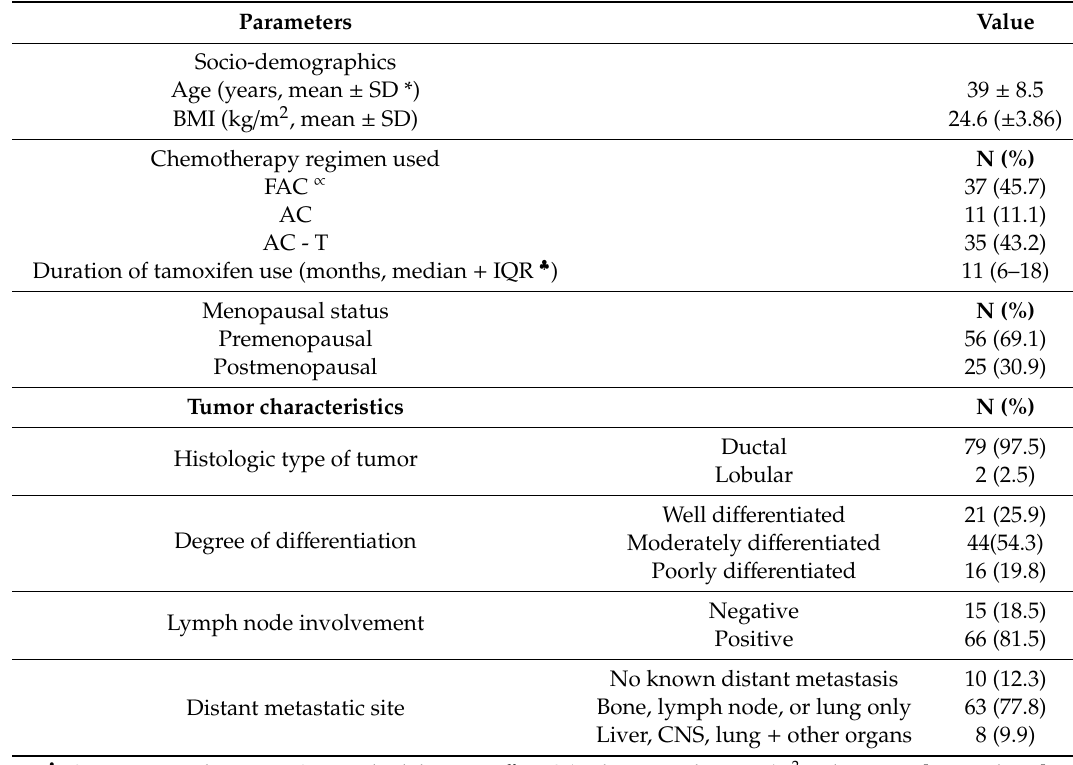
Table 1. Socio-demographic and tumor characteristics of tamoxifen treated breast cancer patients at the radiotherapy center, Tikur Anbessa Specialized Hospital, Addis Ababa, Ethiopia. Parameters